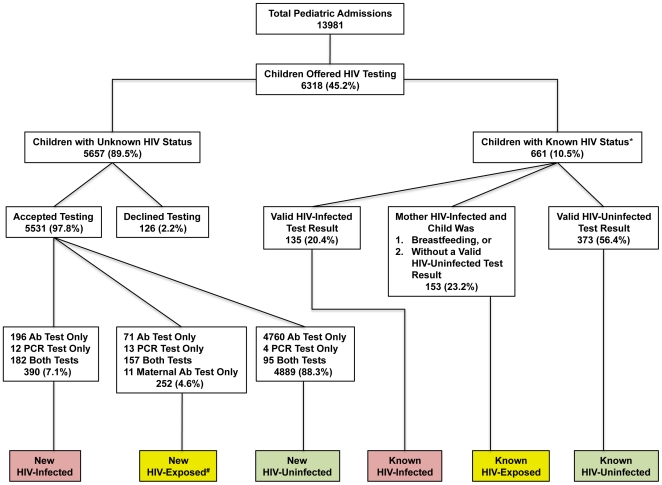
Child PITC Overview at Kamuzu Central Hospital; January 1 - December 31, 2008.Total HIV-infected children (red boxes): 525/6192 (8.5%); total HIV-exposed children (yellow boxes): 405/6192 (6.5%); total HIV-uninfected children (green boxes): 5262/6192 (85.0%). *6 children with known HIV status were incorrectly retested. #158 newly recognized HIV-exposed children had a negative DNA-PCR while breastfeeding, while 12 DNA-PCR results for newly recognized HIV-exposed children were lost. Ab: HIV antibody; PCR: HIV DNA-PCR.